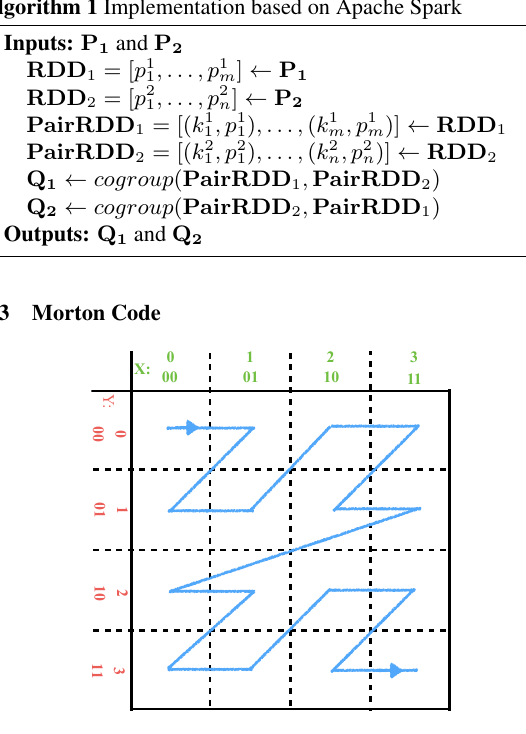
Figure 2. A 2D illustration of morton code.